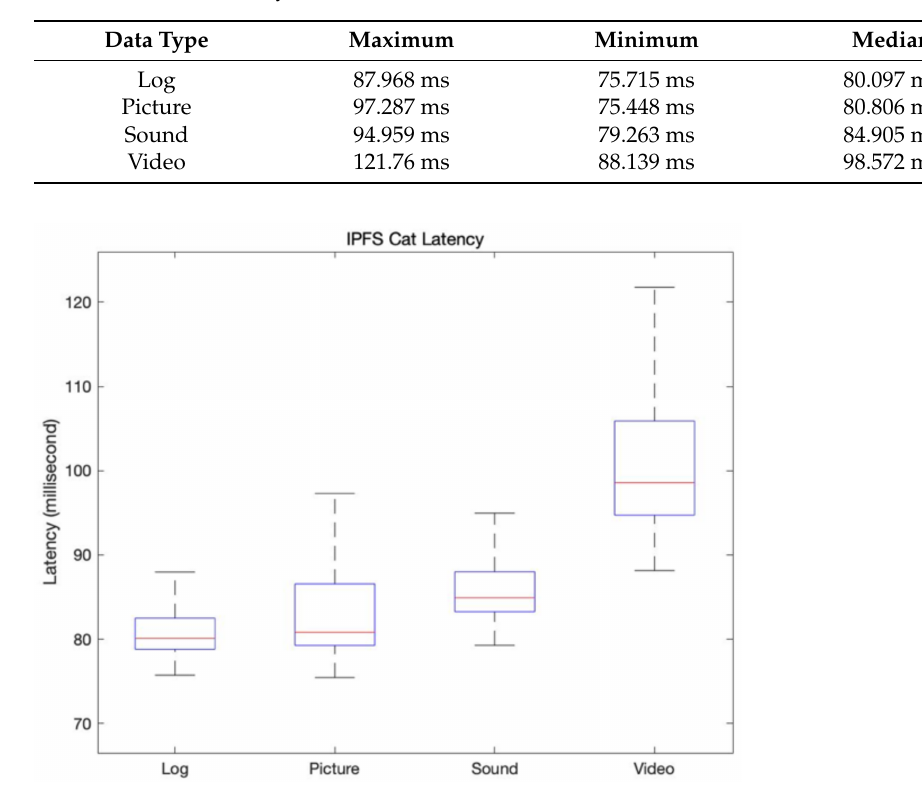
Table 7. IPFS Cat Latency.